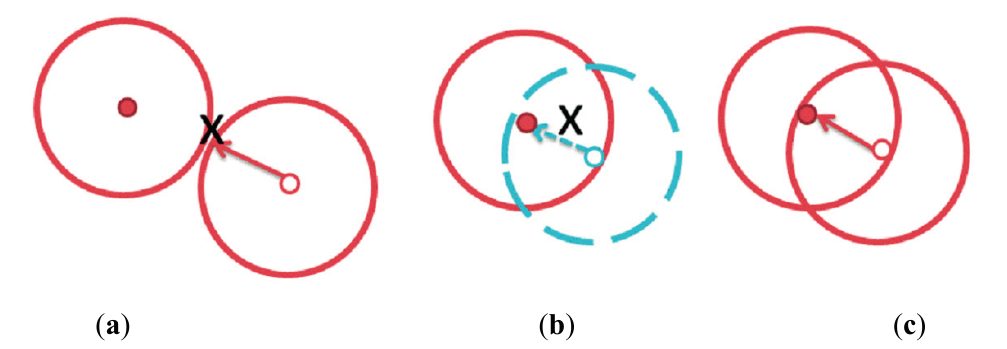
Figure 1. Clustering requirements in a CRSN. The small solid circle represents a cluster head and the small empty circle represents a sensor node attempting to locate a cluster head. The large circles represent the sensor’s transmission range. ( a ) The sensor nodes cannot identify the cluster head because the cluster head is located outside its transmission range. ( b ) The sensor node and the cluster head are using different channels and, thus, even though the cluster head is located inside the sensor node’s transmission range, the sensor node cannot find the cluster head. ( c ) The sensor node and the cluster head are using the same channel, and the cluster head is located inside the sensor node’s transmission